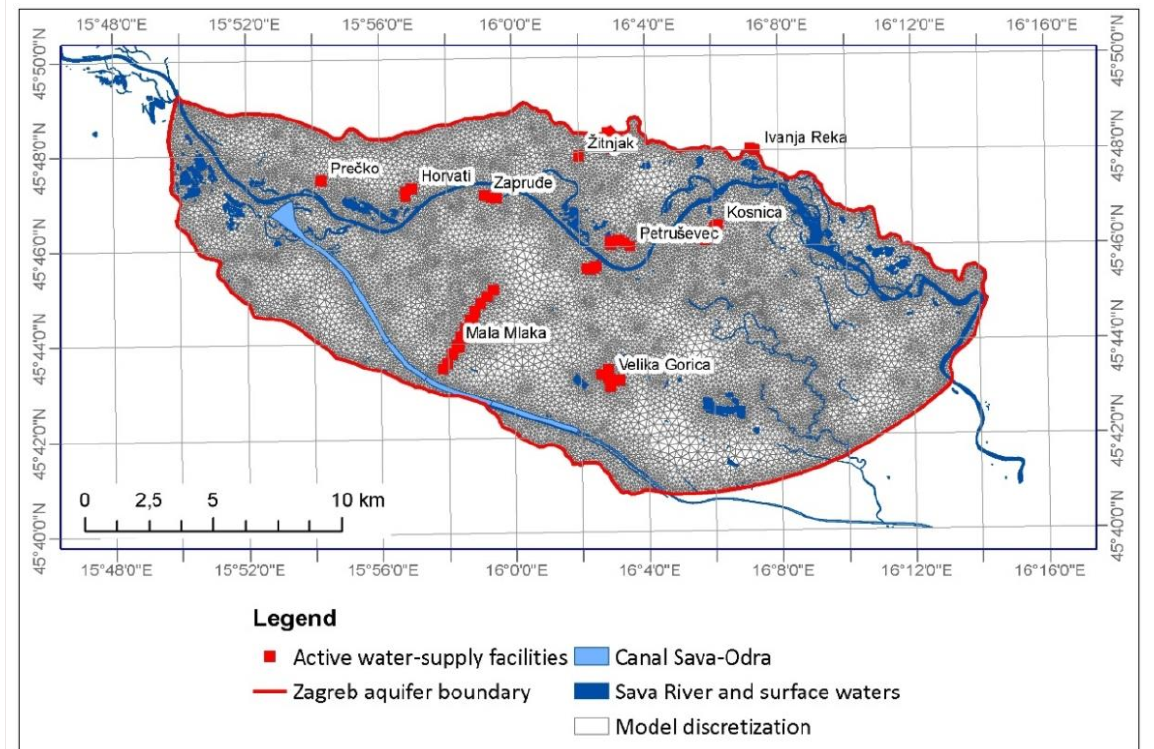
Figure 4. Discretization of the Zagreb aquifer